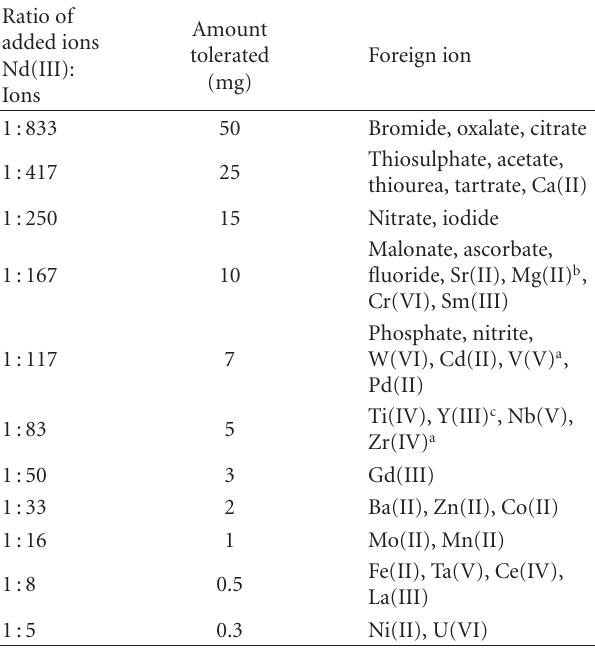
Table 7: Separation of neodymium(III) from synthetic mixture.